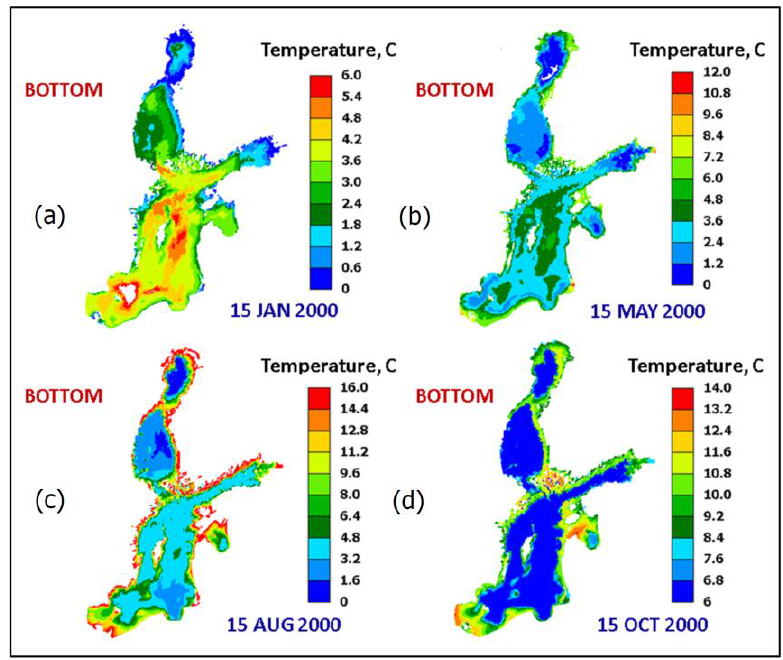
Figure 12. Seasonal bottom temperature contour plots for the year 2000. ( a ) Winter; ( b ) Spring; ( c ) Summer; ( d ) Autumn.